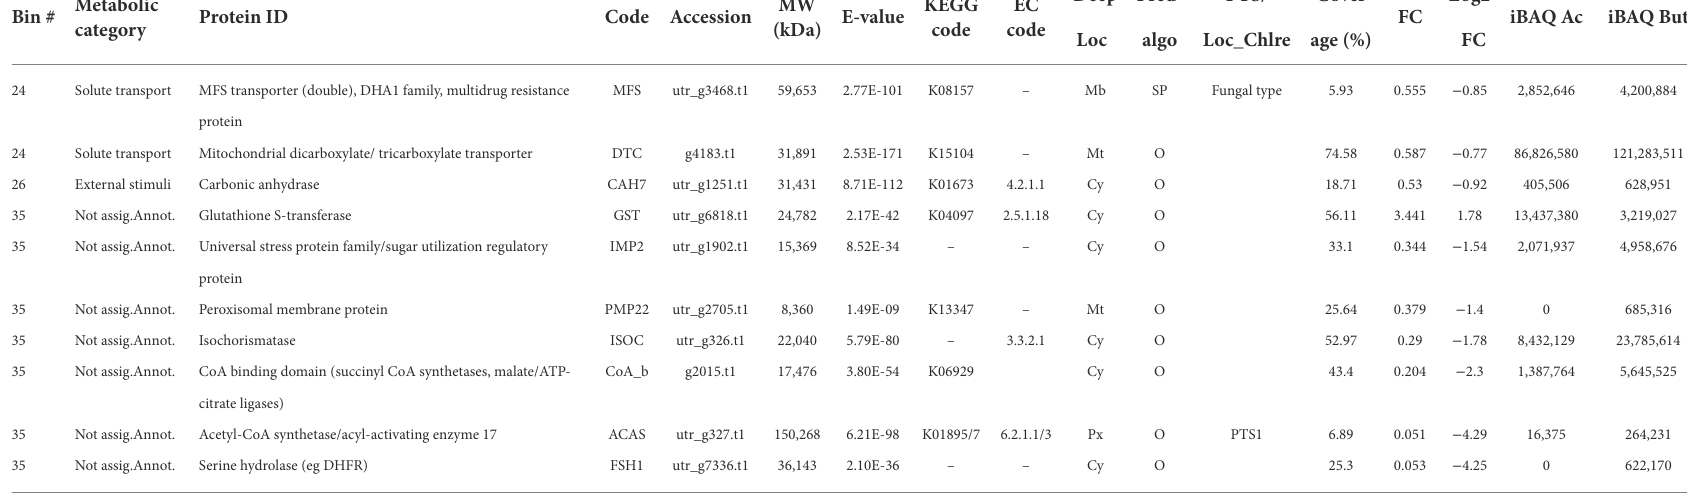
Not assig.Annot. Acetyl-CoA synthetase/acyl-activating enzyme